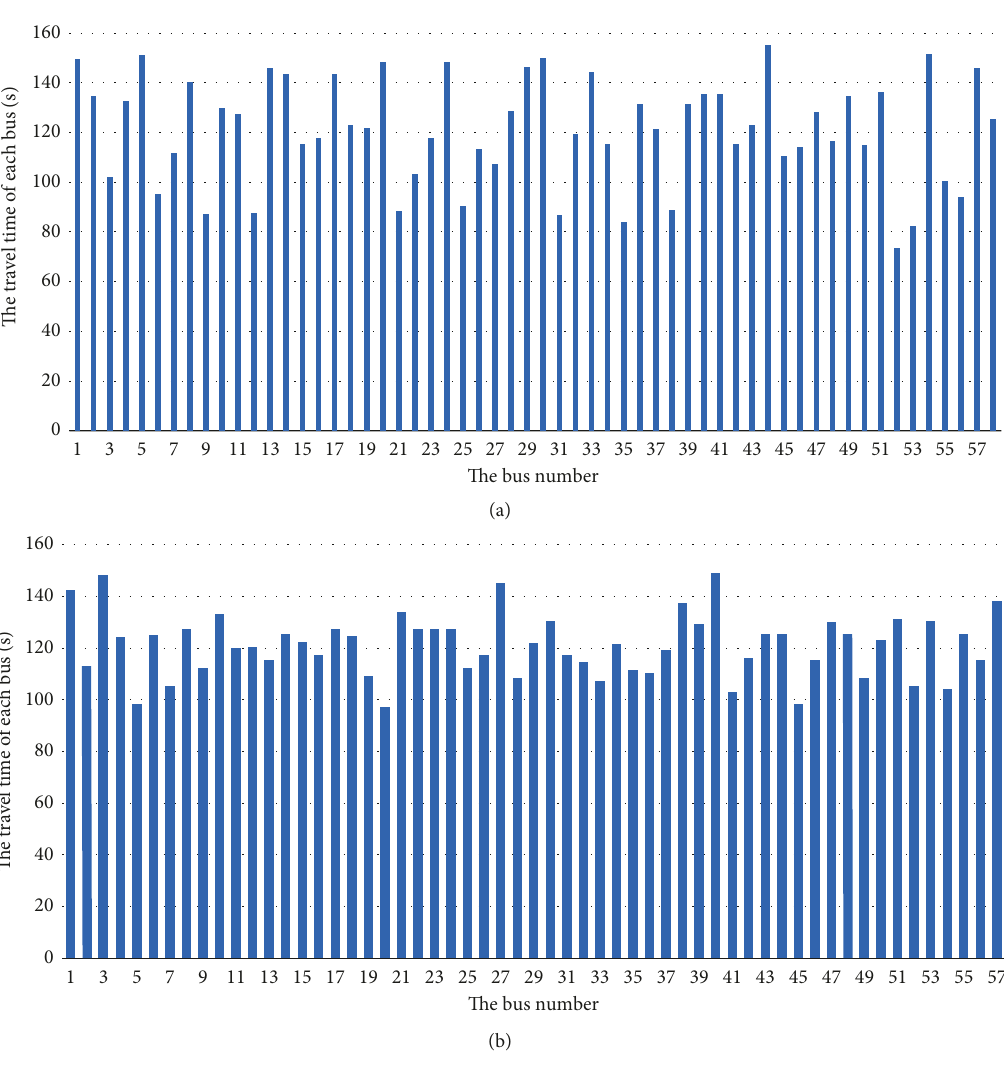
Figure 12: The travel time of each bus. (a) The travel time of each bus in Group A. (b) The travel time of each bus in Group B.